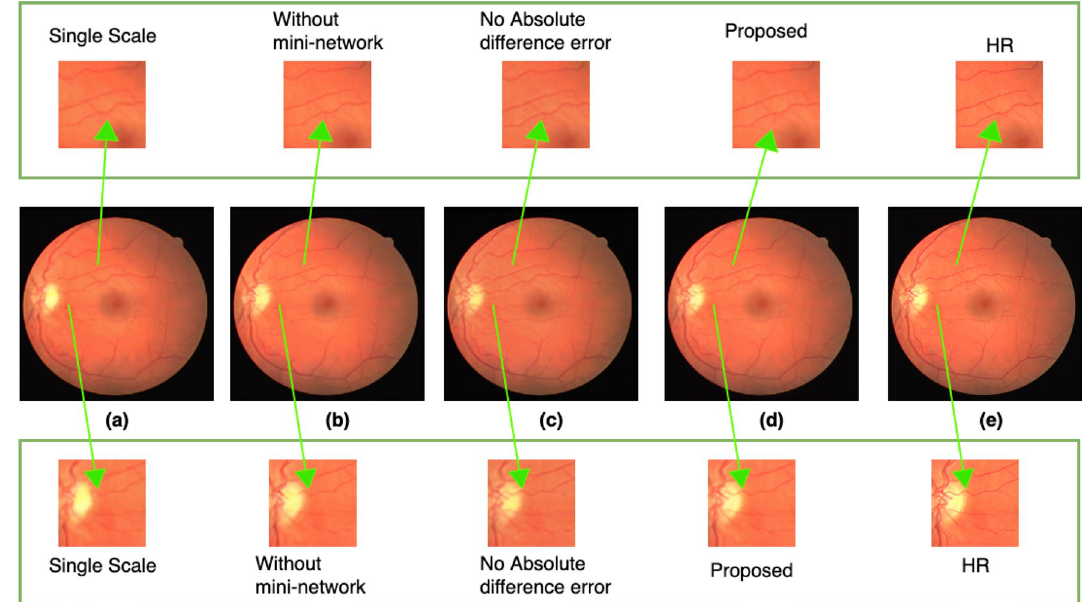
Figure 16. Results for ablation studies. The upper and lower rows show the extracted small region. ( a ) Represents the resultant SR image with single scale features extraction. ( b ) Represents the resultant SR image for experiment without the mini-network. ( c ) Represents the resultant SR image for experiments after removing the absolute difference error term from the loss function. ( d ) Represents the resultant SR image for experiment with the overall proposed method. ( e ) Represents the corresponding HR ground truth image. Arrows point to the extracted small regions to highlight the regions where difference